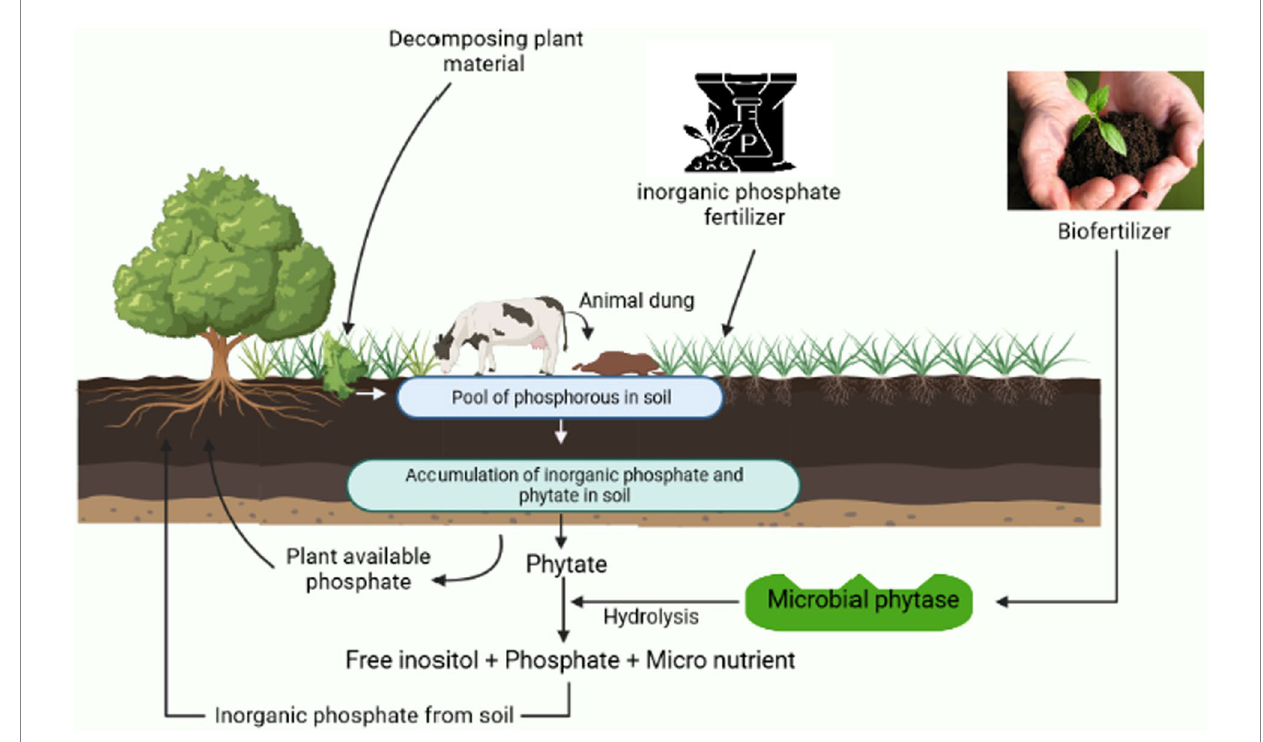
FIGURE 5 An overview to demonstrate the cyclic working process of a biofertilizer and the role of microorganisms in phytate